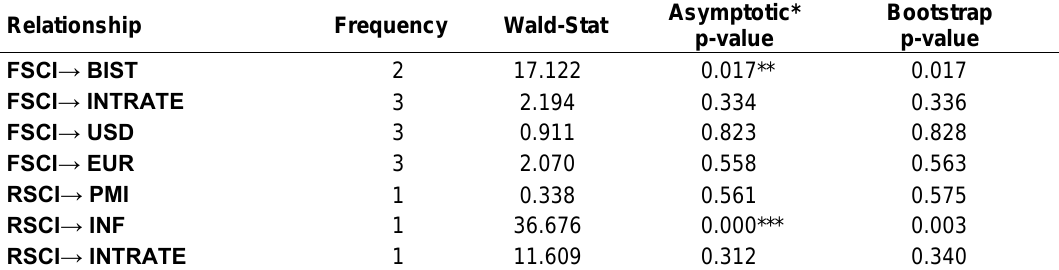
Table 5. Fourier Toda Yamamato Causality Test